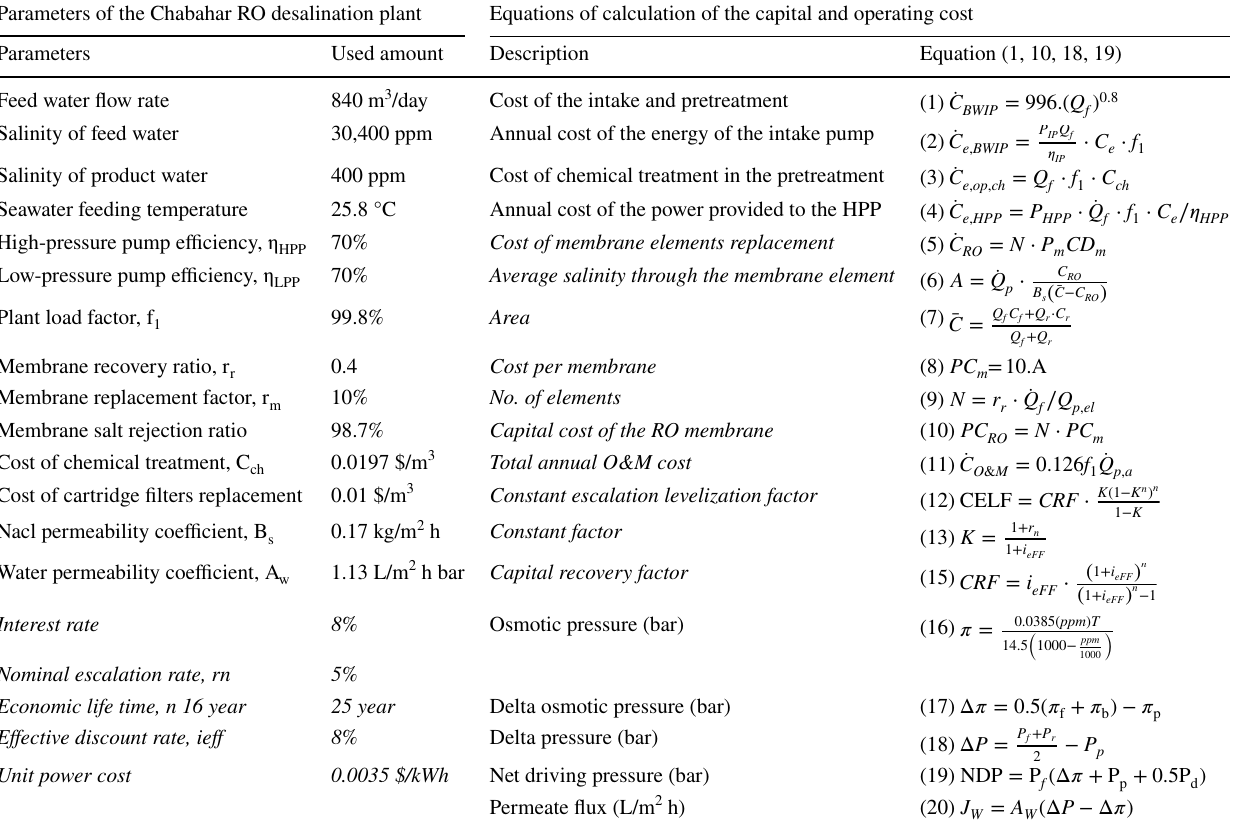
Table 2 Equations and parameters of cost analysis Parameters of the Chabahar RO desalination plant Equations of calculation of the capital and operating